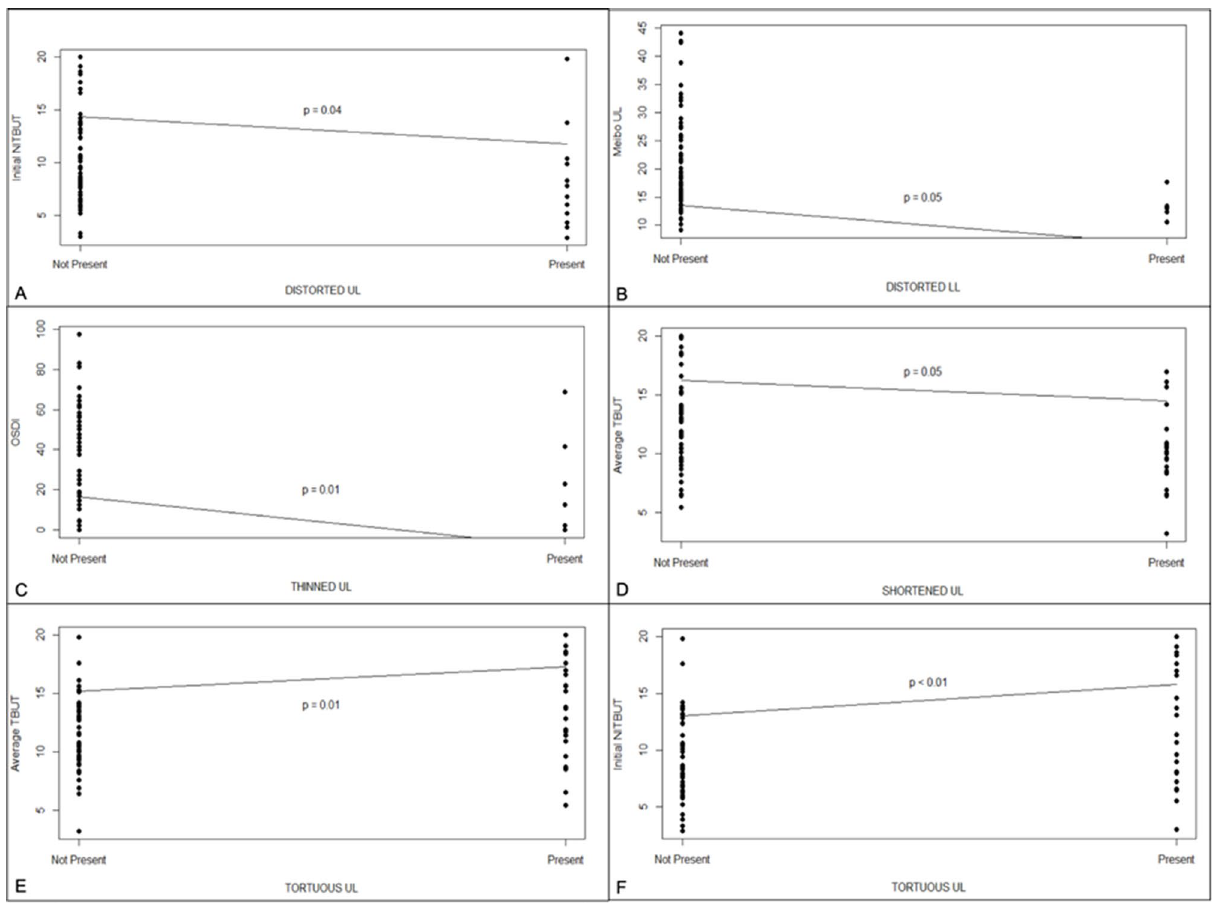
Figure 1. Logistic regression between clinical parameters and morphological characteristic ( A ) initial NITBUT (TBUT_I) on distorted glands in upper eyelids (UL). ( B ) Logistic regression of meiboscore on distorted glands lower eyelids (LL). ( C ) Logistic regression of OSDI on thinned glands in UL. ( D ) Logistic regression of average TBUT (TBUT_A) on shortened glands in UL. ( E ) Logistic regression of average TBUT (TBUT_A) on tortuous glands in UL. ( F ) Logistic regression of initial NITBUT (TBUT_I) on tortuous glands in